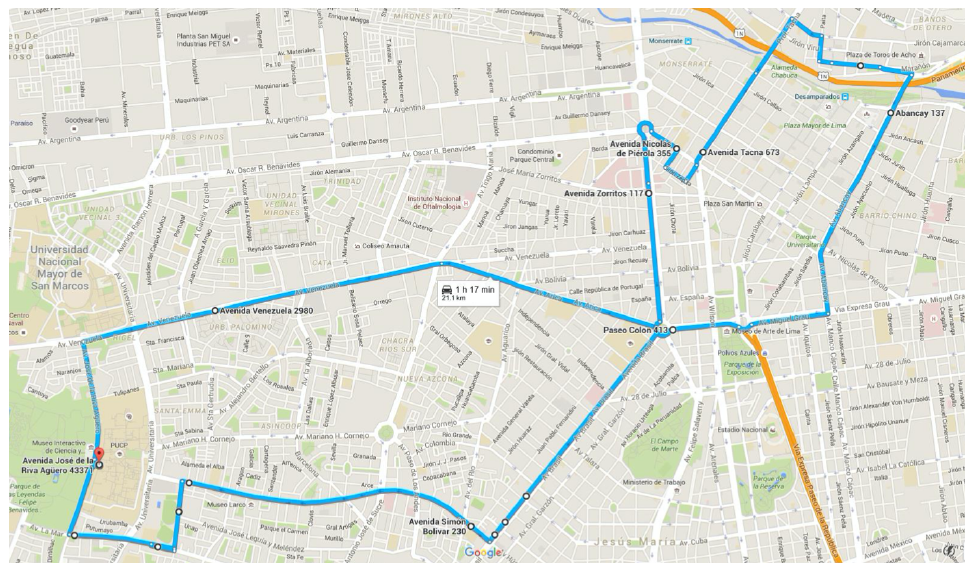
Figure 1. Circuit for CST in Lima Metropolitana.